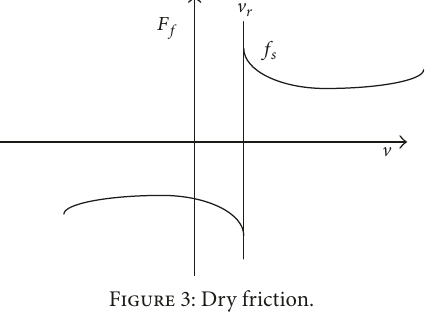
Figure 3: Dry friction.